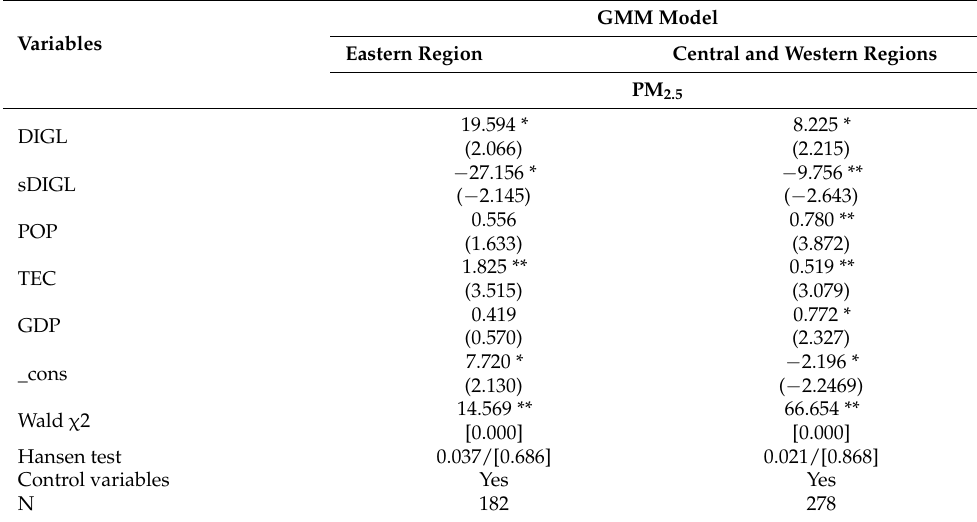
Table 8. Analysis of the regional heterogeneity of digitalization on PM 2.5